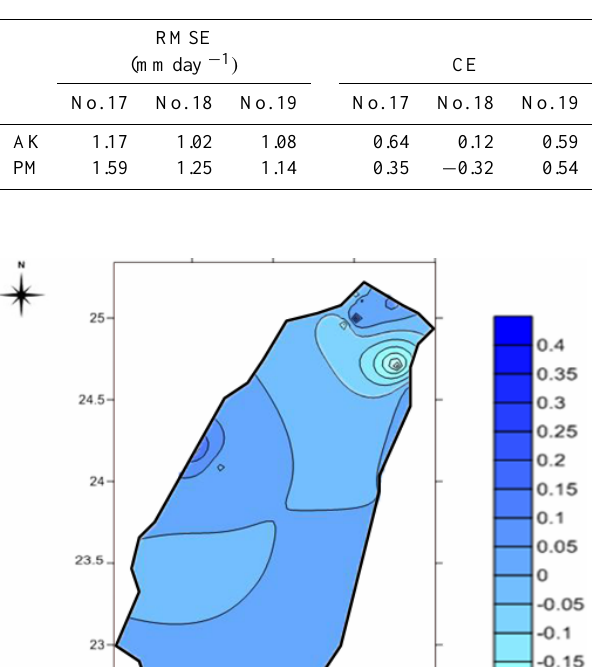
Table 4. Performance of the AK and PM models at individual me- teorological station.